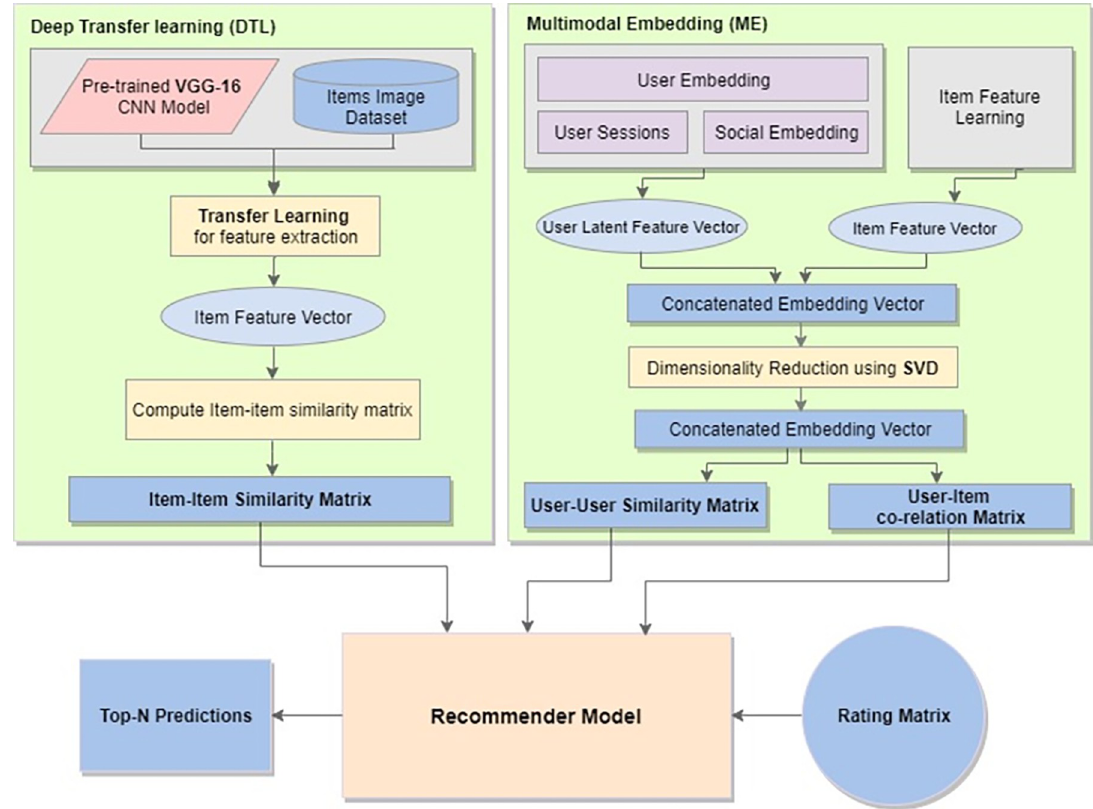
Fig 1. The architecture of the proposed DTLME model for feature